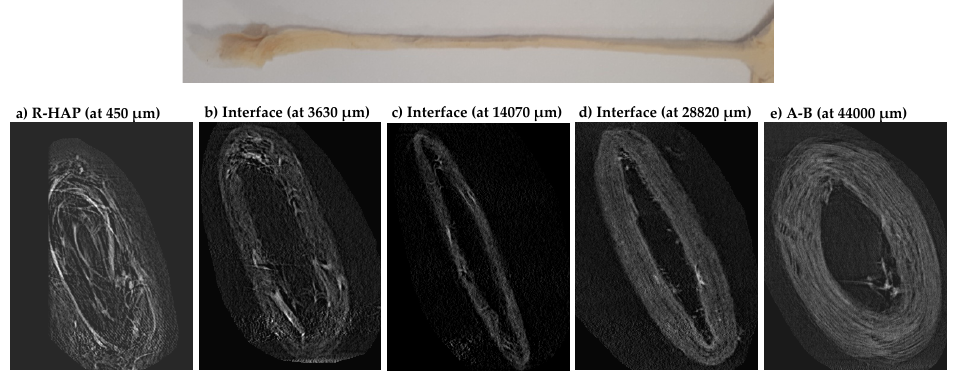
Figure 6. Micro CT images of the cross-sections acquired along the length of tubular scaffold from ( a ) the bone part (R-HAP), to ( e ) the tendon part (A-B), throughout ( b ), ( c ), and ( d ) the interface area.